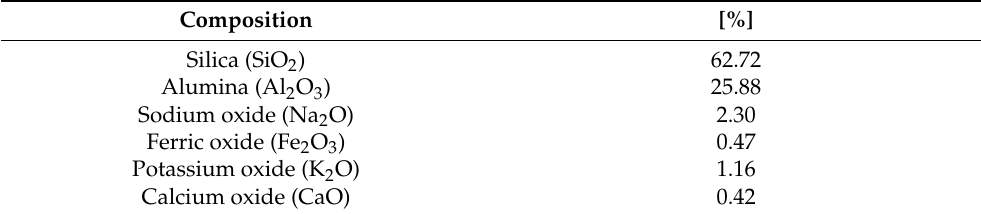
Table 1. Bioceramics chemical composition.